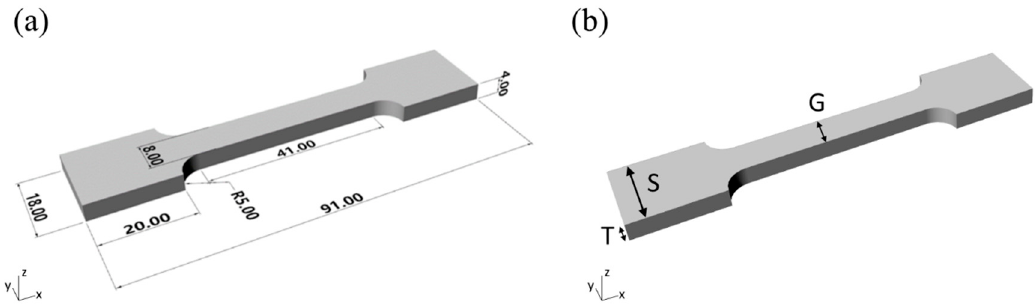
Figure 1. Tensile sample details. ( a ) Nominal dimensions (expressed in millimeters). ( b ) Measured thickness (T), gauge width (G), and shoulder width (S). thickness (T), gauge width (G), and shoulder width